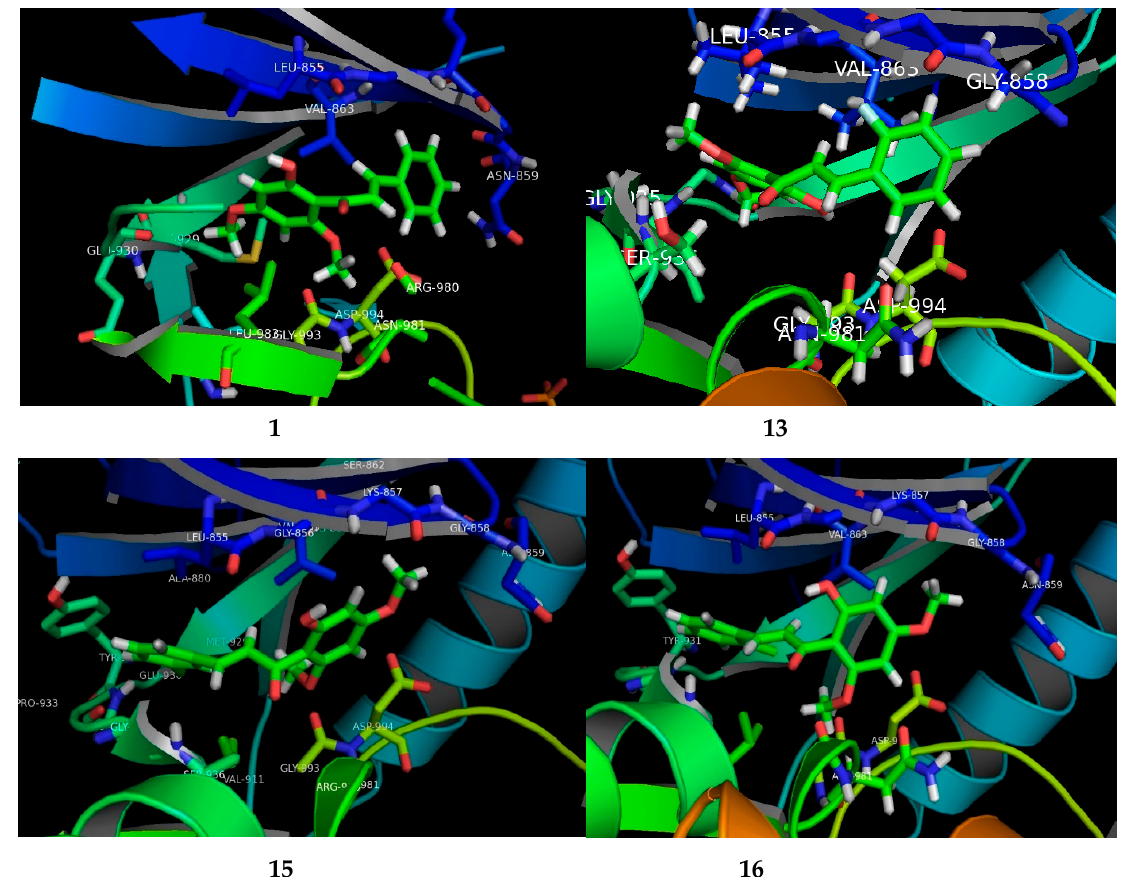
Figure 3. The visual presenting the interaction of FKB derivatives ( 1 , 13 , 15 and 16 ) with the ATP binding site of human JAK2 tyrosine kinase. binding site of human JAK2 tyrosine